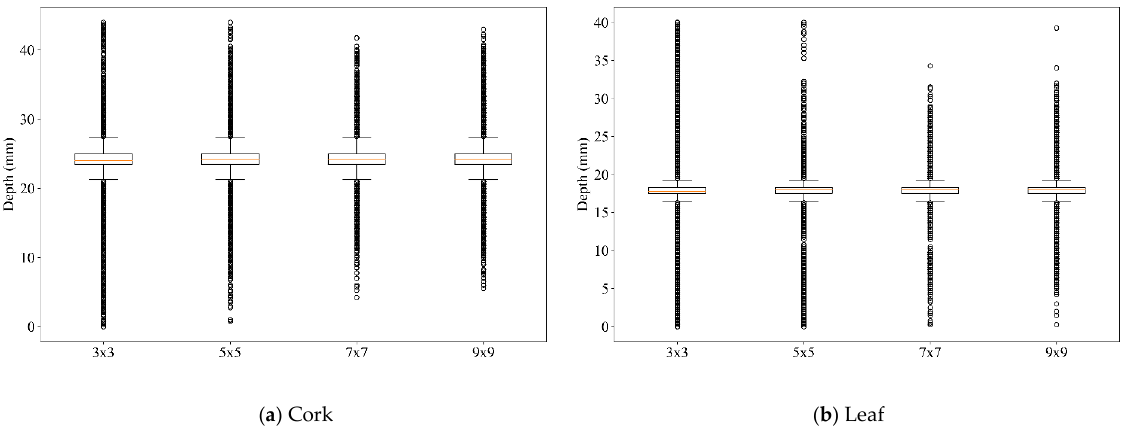
Figure 11. Depth map of the real objects ( Upper : cork, lower : leaf).